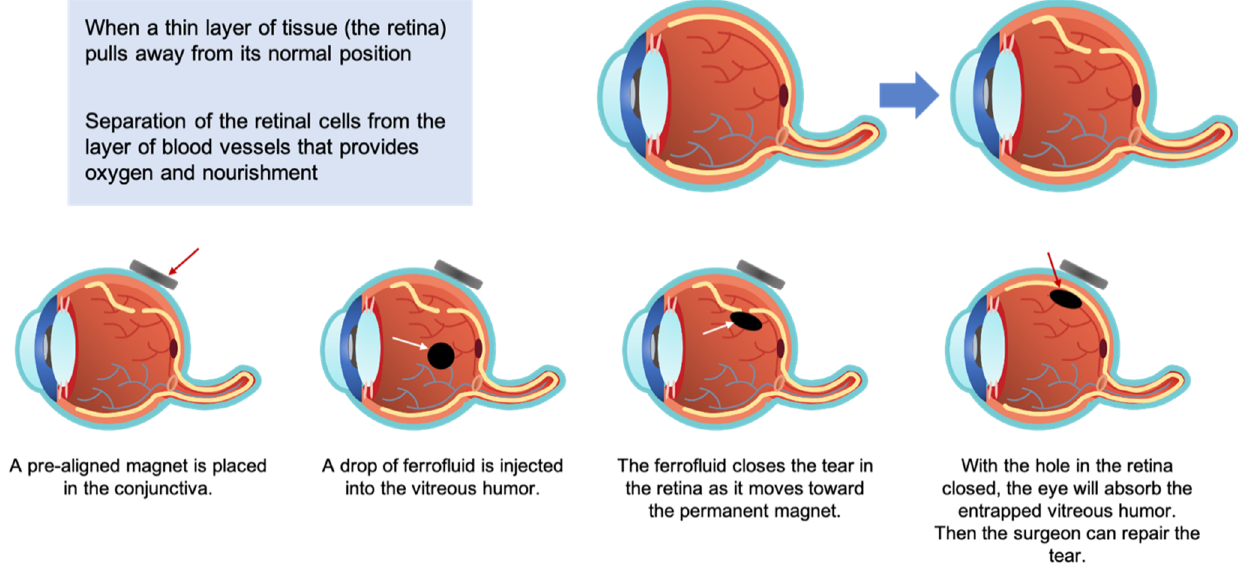
Figure 9. Retinal repair utilizing macromer-enabled magnetorheological fluids.